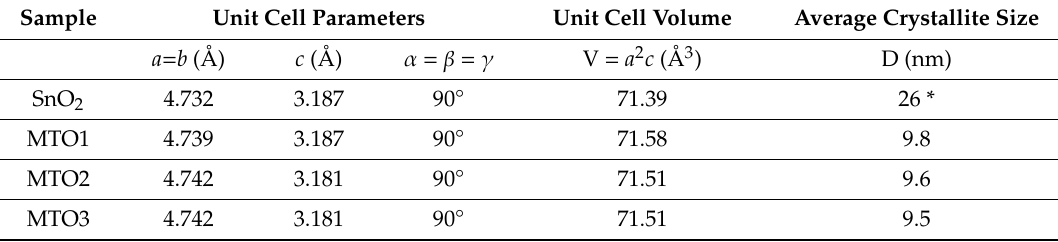
Table 1. Lattice parameters and average crystalline size of the Mg-doped SnO 2 thin films.